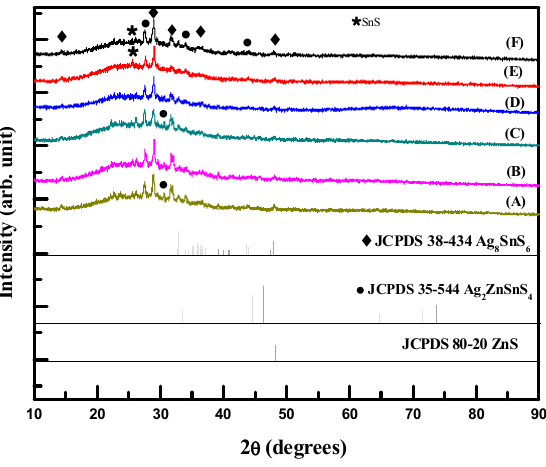
Figure 1. XRD patterns of samples prepared in this study.